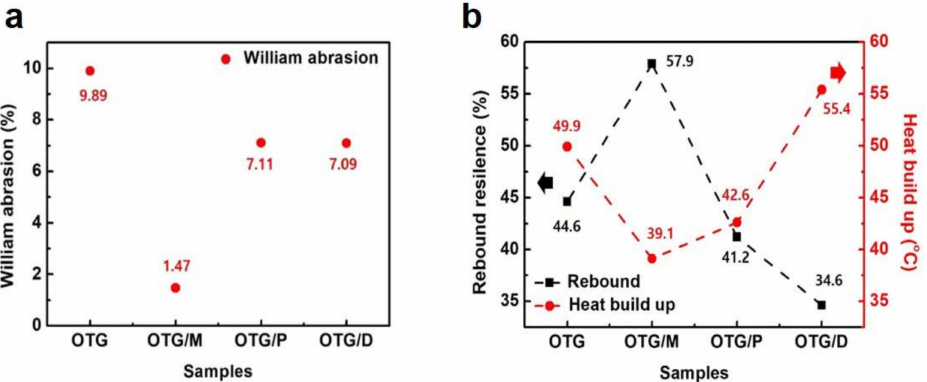
Figure 6. Abrasion, heat build-up properties of elastomer composites. ( a ) William abrasion of the elastomer nanocomposites with hybrid oils. ( b ) Rebound resilience and heat build-up of the elastomer composites with hybrid